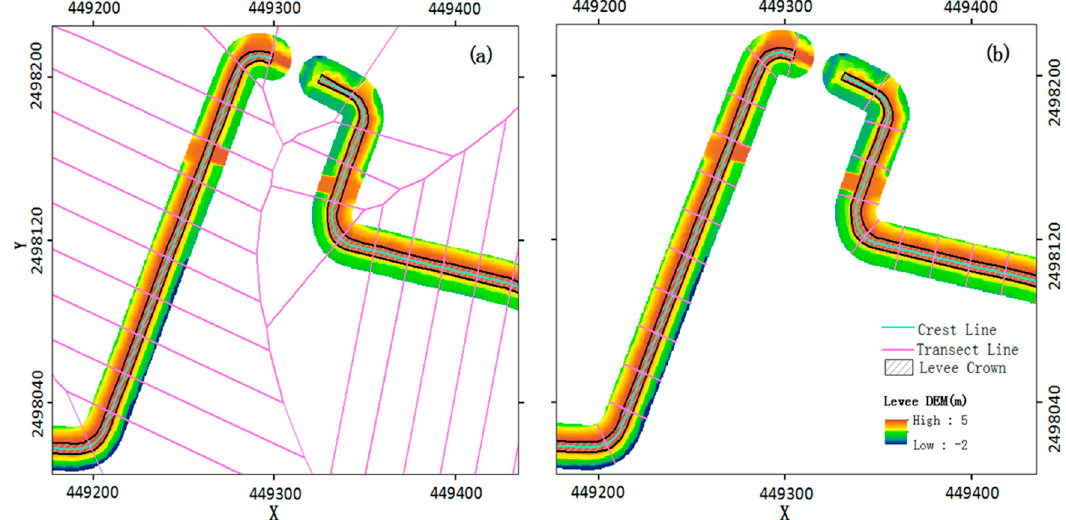
Figure 4. ( a ) Thiessen polygons generated from the levee crown central line at a 100m interval, and ( b ) the levee transect lines generated by the Thiessen polygons and the outlines of levee crown and toes. The blank area in levee is a sluice for a local channel.